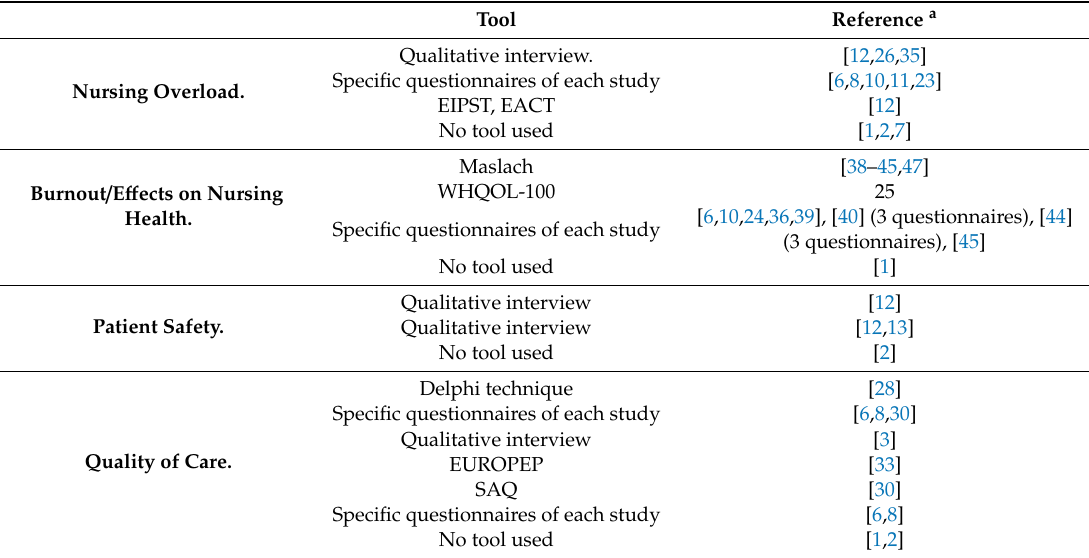
Table 1. Tools used in the